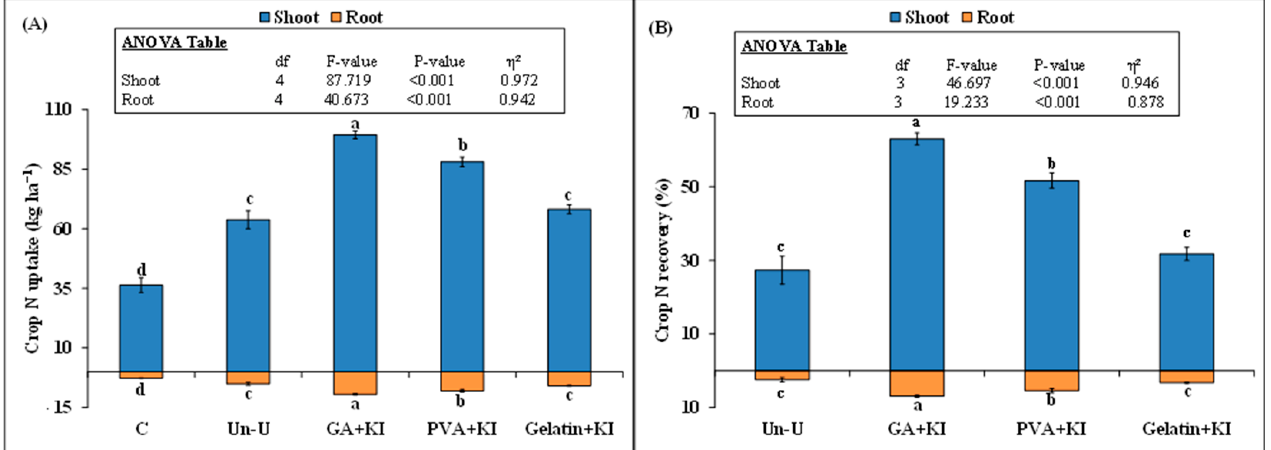
Figure 7. Mean (n = 3) wheat plant N uptake ( A ), and apparent N recovery (ANR) ( B ) from uncoated and coated urea fertilizers. Abbreviations of fertilizer treatments can be seen in Figure 1. C stands for untreated control treatment. Error bars show standard errors (±1 SE) of the mean. Different capital or small letters illustrate significant differences among treatments at a 5% probability level after the Tukey ‐ HSD test. The inset table represents the outcomes of the analysis of variance (ANOVA).